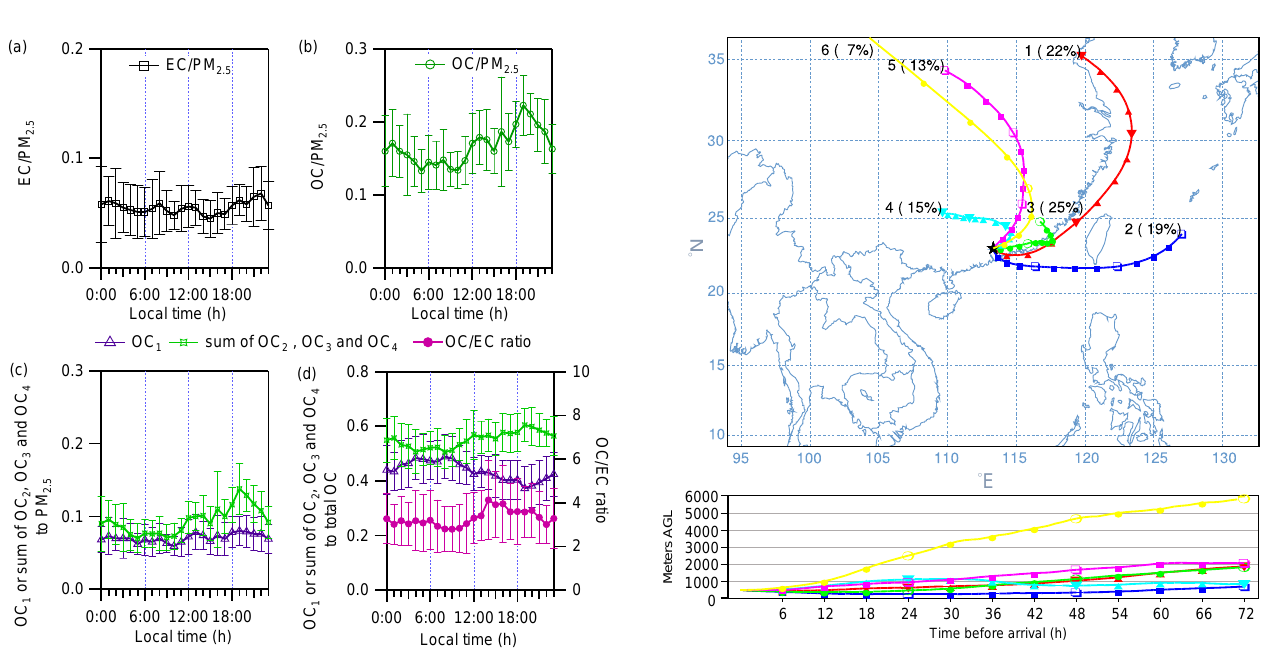
Figure 6. Diurnal variations in the mass fractions of EC, OC, and OC 1 and the sum of OC 2 , OC 3 and OC 4 in PM 2 . 5 , the OC-to-EC ratio, mass fractions of OC 1 and the sum of OC 2 , OC 3 and OC 4 to total OC in February and March 2014. Error bars represent 1 standard deviation.